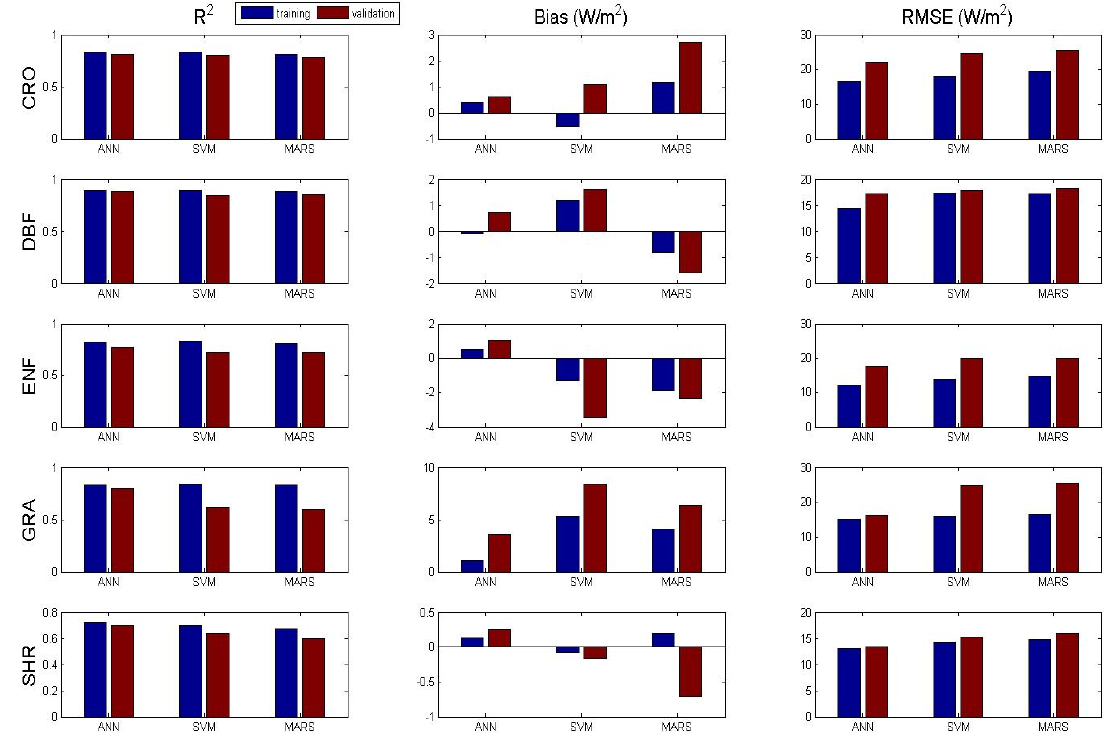
Figure 5. Bar graphs of the training and validation statistics (R 2 , Bias and root mean square error (RMSE)) of three algorithms driven by tower-specific meteorology for five PFTs at the 85 flux tower site. All R 2 values are significant with a 99% confidence.